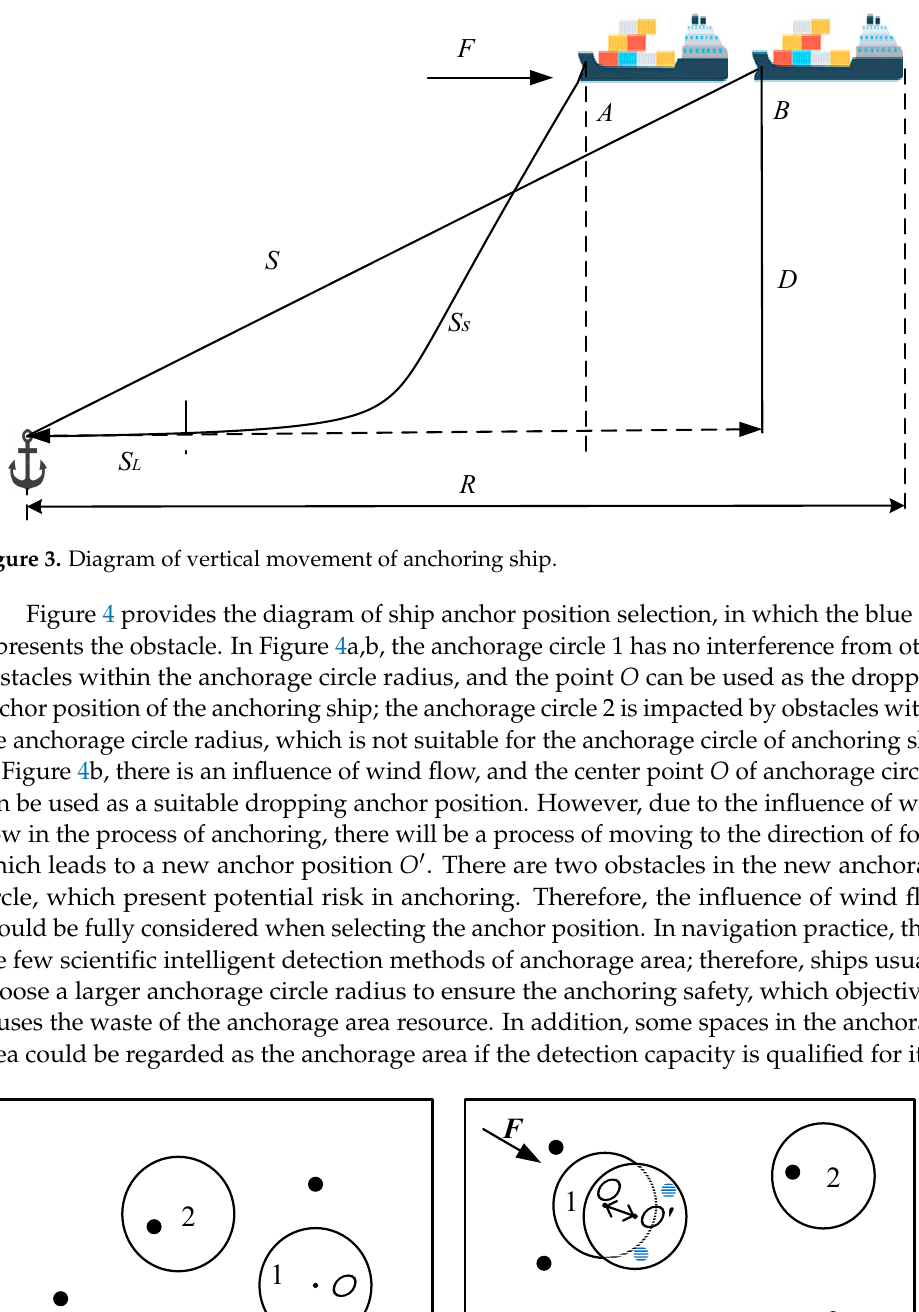
Figure 3. Diagram of vertical movement of anchoring ship.